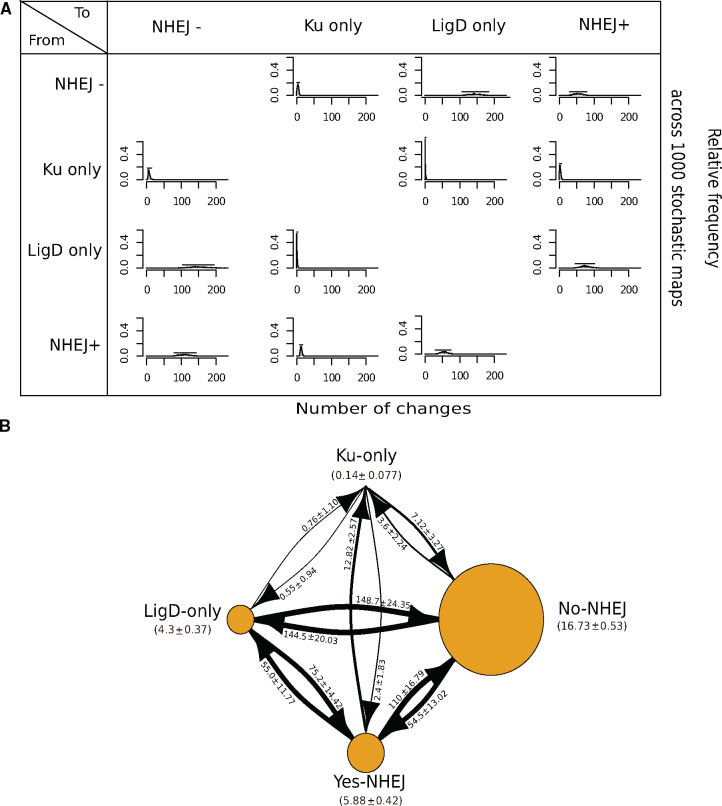
Transitions to a Ku only state are rare. (A) A matrix depicting relative frequency of number of changes of a state transition type across 1,000 stochastic maps. (B) A state transition diagram depicting the number of transitions between two given states and the time spent in each state during NHEJ evolution. The node size is proportional to the amount of time spent in a particular state. The arrow size is proportional to the number of transitions from one state to another.